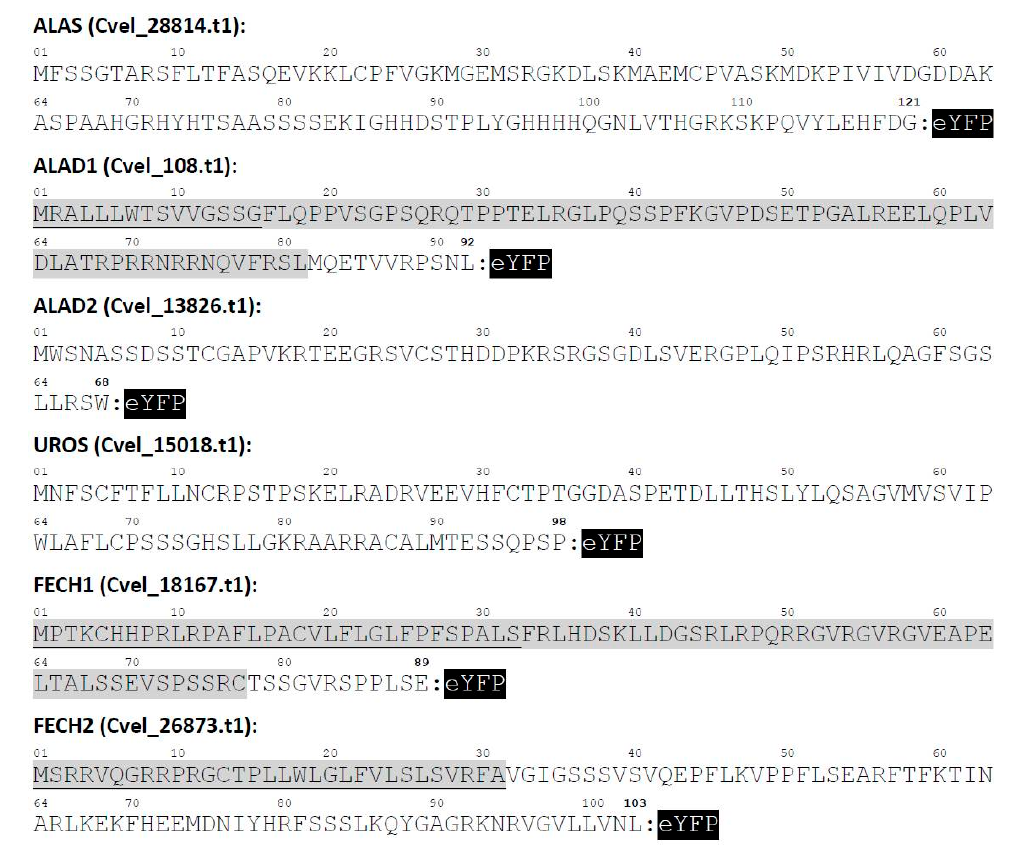
Figure 4. Constructs for heterologous expression of P. tricornutum and T. gondii with truncated C. velia proteins. Numbers above the aa sequence correspond to amino acid position in the protein. Presequences are marked in grey, predicted SPs are underlined. Enhanced yellow fluorescent protein used to tag the construct is displayed as acronym (eYFP) in a black box. CryptoDB accession numbers of proteins are given in parenthesis behind the protein name.